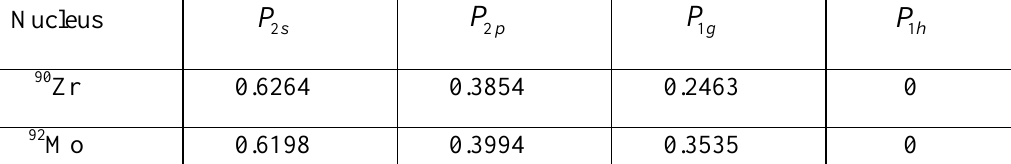
Table 4: Proton occupation probabilities of the shell 2s, 2p, 1g, 1h of the nuclei. Nucleus